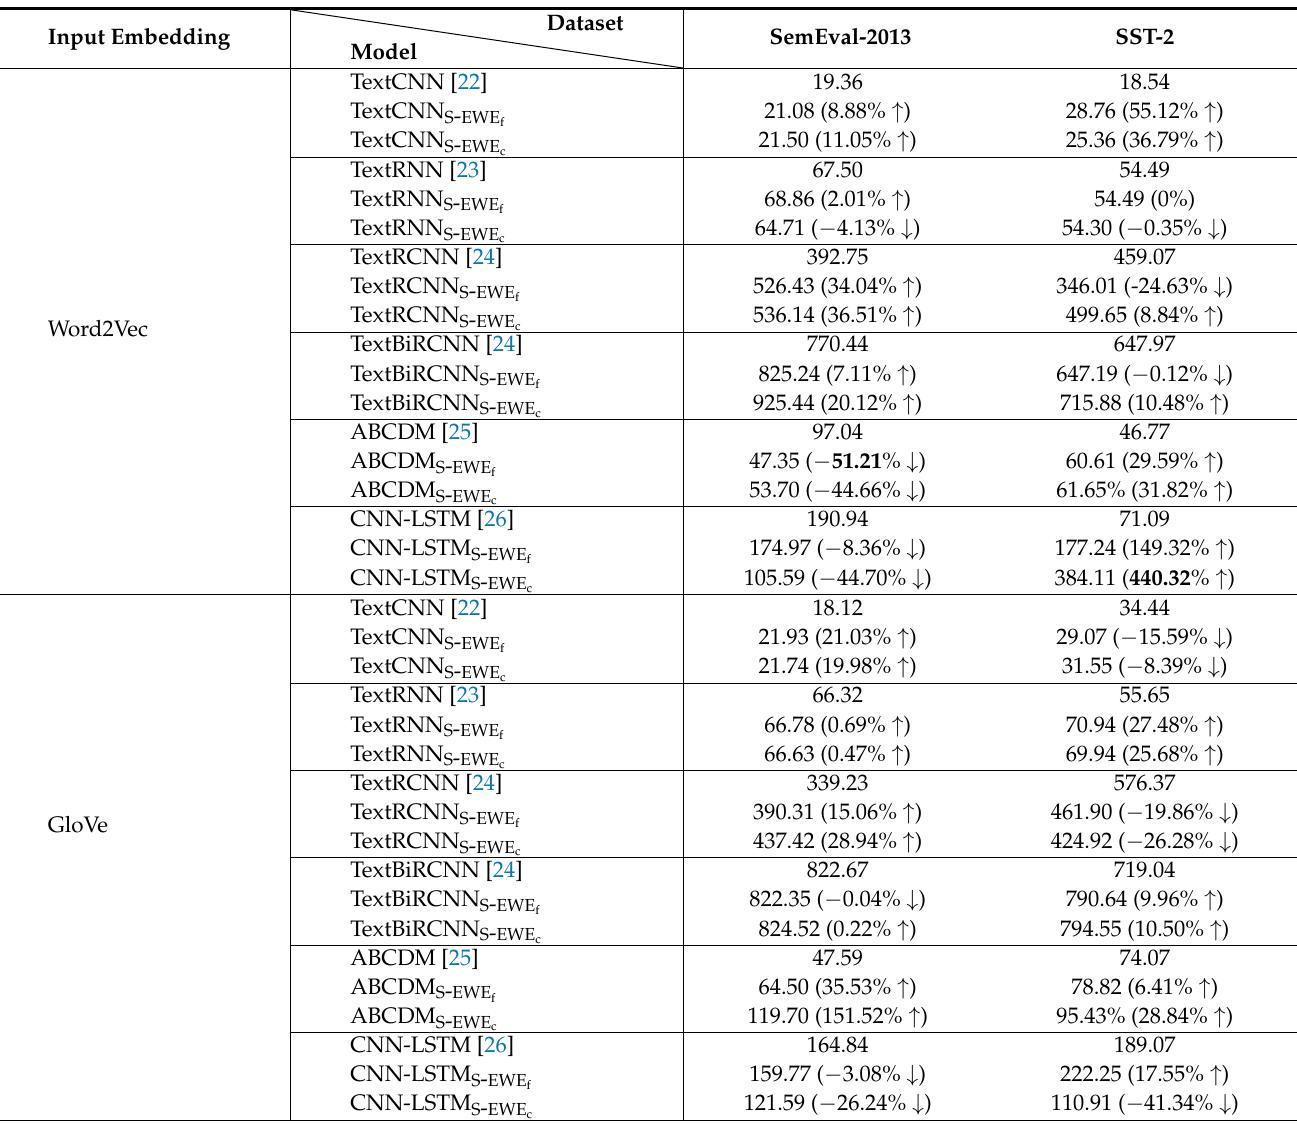
Table 7. Comparisons with the convergence times of TextCNN, TextRNN, TextRCNN, TextBiRCNN, ABCDM, and CNN-LSTM using Word2Vec and GloVe with or without S-EWE c and S-EWE f on two datasets. The contents in parentheses indicate the increased or decreased convergence speeds compared to the original models